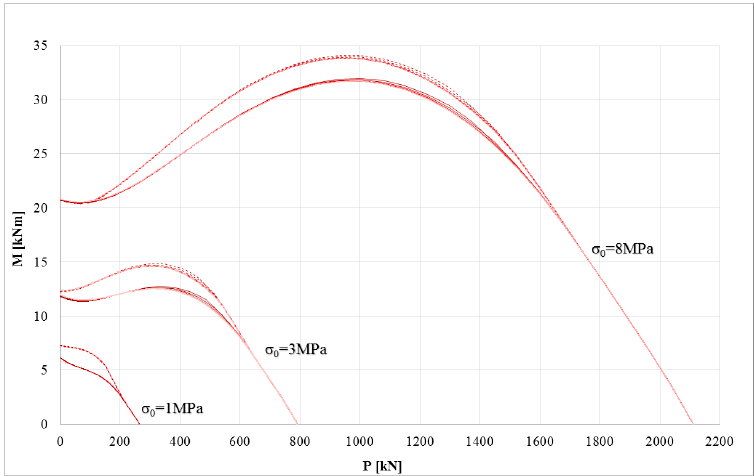
Figure 3 . P (axial load)-M (bending moment) domains of the strengthening system with synthetic fiber: bi-linear model (dotted line), linear model (solid line).